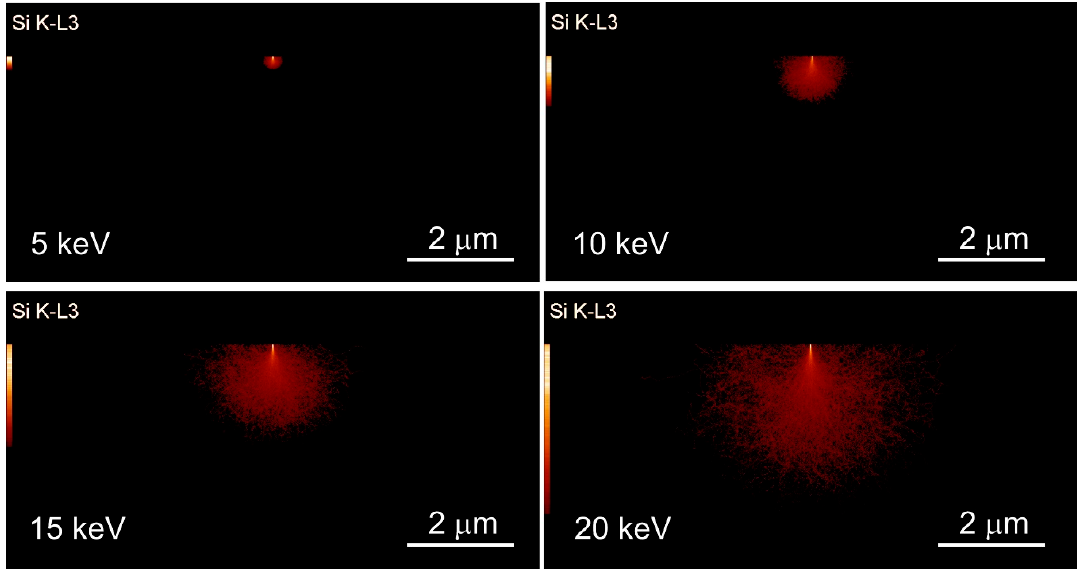
Figure 1. Monte Carlo calculations of the X-ray generation volume for the Si line K α 1 (K-L 3 ) in a prismatic Egyptian blue fragment with a thickness of 10 µ m at 5, 10, 15 and 20 keV. For the sake of simplicity and clearness, a 2D section of only the upper part of the prismatic sample (dark area) of size 4 µ m (height) and 10 µ m width is reported. The electron probe (5 nm) is placed on the top side of the pigment and focused on its middle position.